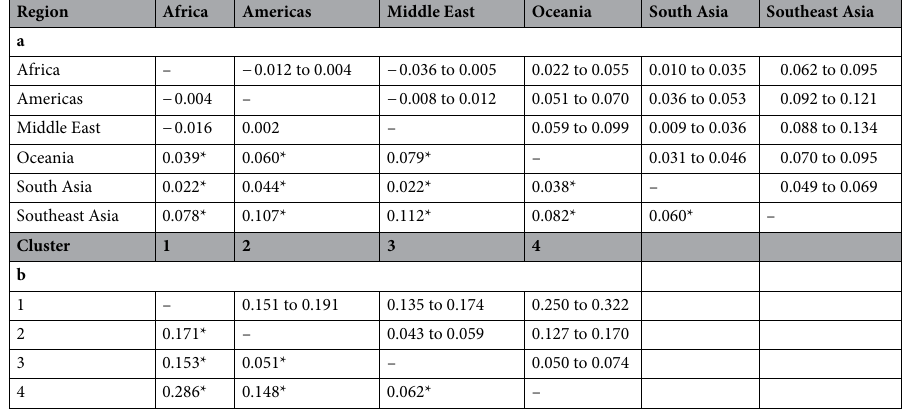
Table 3. Pairwise F ST for M. indica . a) F ST estimates for the geographical regions and b) clusters. F ST estimates are below the diagonal, 95% confidence interval above the diagonal are based on 1000 bootstrap replicates. Clusters (K = 4) were identified using hierarchical cluster analysis (Fig. 1). *95% confidence intervals do not overlap with 0.